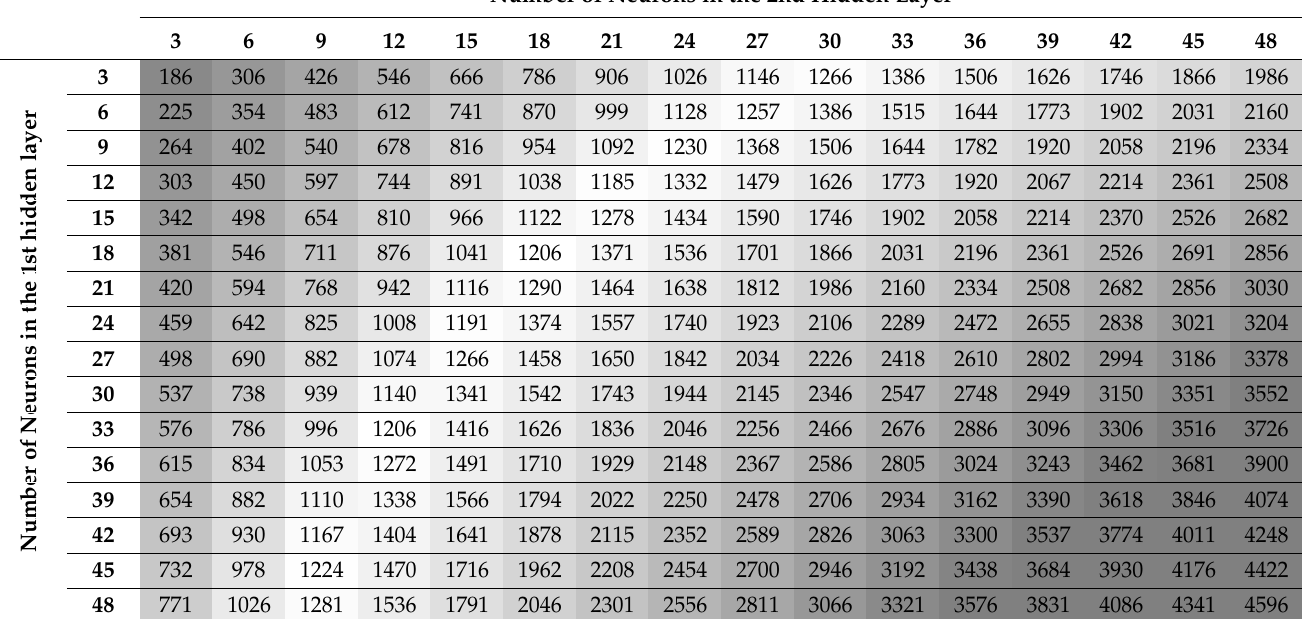
Table 5. Number of coefficients for 3RGB 2HL ANN models in step 3 for the number of neurons in the 1st and 2nd hidden